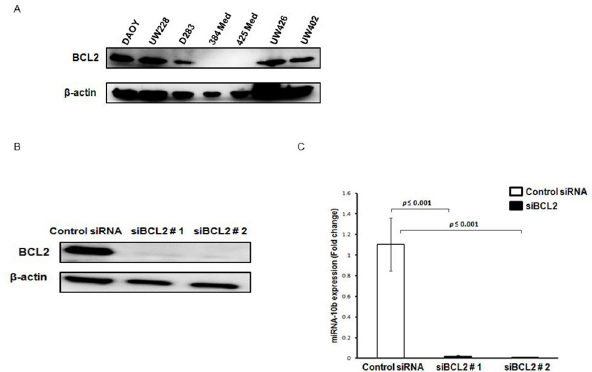
Fig 4. Knockdown of BCL2 by specific siRNA induces significant inhibition of miRNA-10b expression. DAOY, UW228, D283 384 Med, 425 Med, UW426 and UW402 medulloblastoma cells were collected and lysed, and cell lysates were fractionated by sodium dodecyl sulfate polyacrylamide gel electrophoresis (SDS-PAGE) and transferred onto PVDF membranes to determine BCL2 protein expression by Western blot analysis. The membrane was stripped and reprobed with an anti- β -actin antibody to confirm equal loading of protein in each lane. (B) DAOY cells were transfected with two different siRNAs (# 1 and #2) (10nM) specific for the BCL2 transcript, or with scrambled universal negative control RNA duplex (DS Scrambled Neg) (10nM). After 48 hours, cells were collected and BCL2 and β -actin expression was determined. (C) After 48 hours of BCL2 and negative control siRNA (10nM) treatment, total RNA was extracted, and mRNA levels of miRNA-10b were determined by RT-PCR analysis as described in Materials and Methods. Experiments were repeated at least three times. ( ** P (cid:1) 0 . 05 and *** P (cid:1) 0 . 001 according to student ’ s